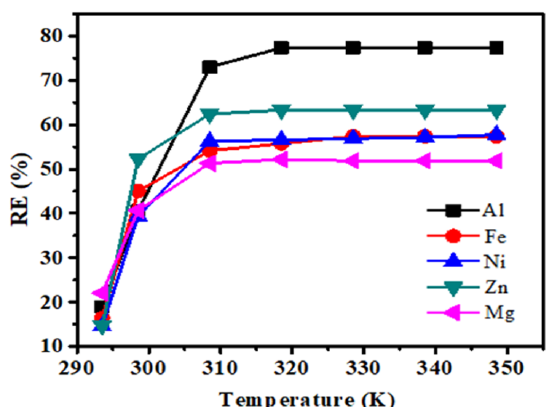
Figure4. EffectoftemperatureonmetaluptakeofAl(III),Fe(II),Zn(II),Mg(II)andNi(II),usingAmberliteIR- Figure 4. Effect of temperature on metal uptake of Al(III), Fe(II), Zn(II), Mg(II) and Ni(II), using 120 (time contact, 15 min; sorbent dose, 0.02 g; stirring speed, 150 rpm). AmberliteIR-120 (time contact, 15 min; sorbent dose, 0.02 g; stirring speed, 150 rpm).